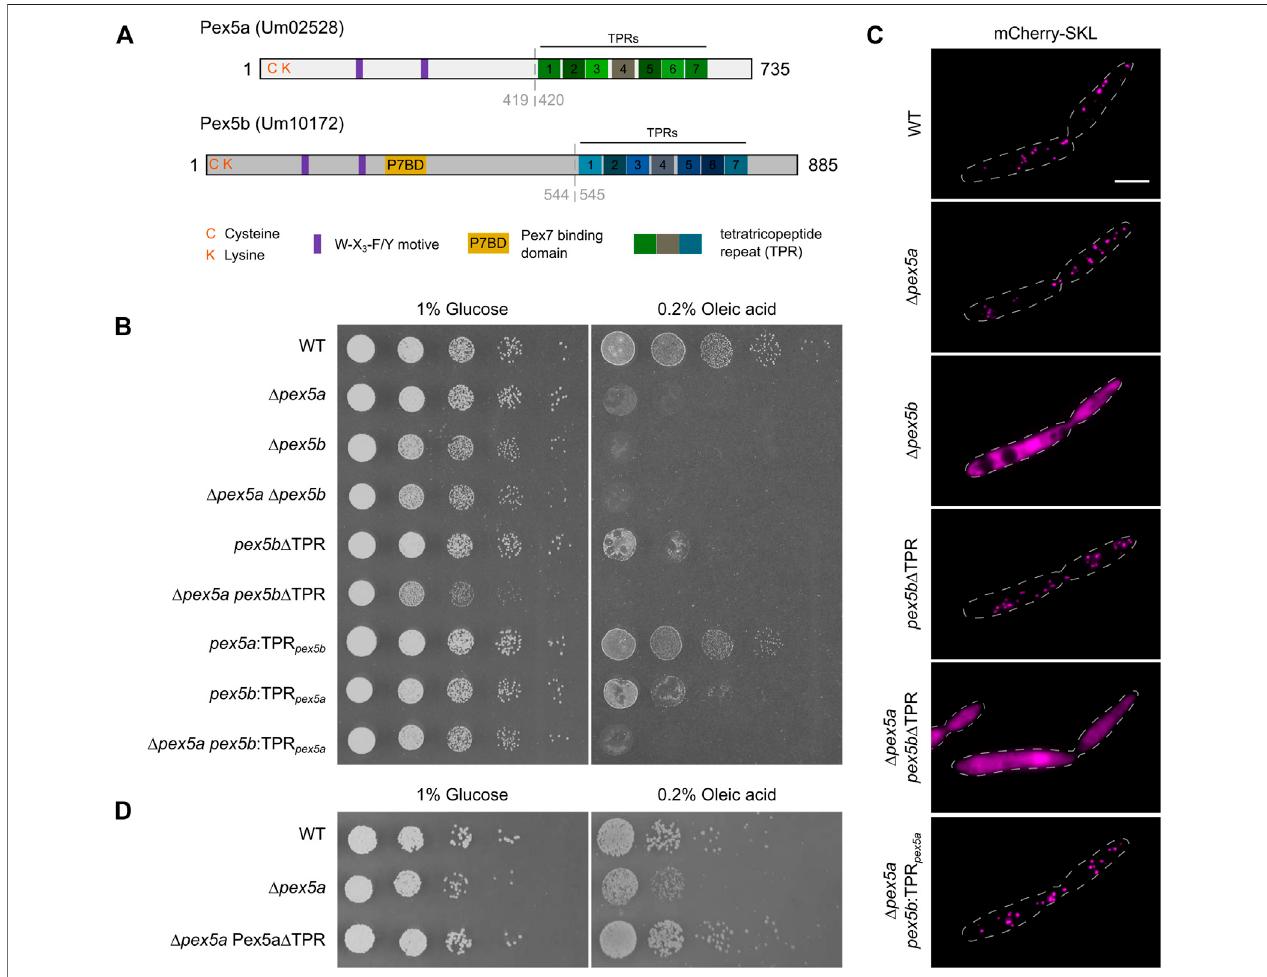
FIGURE 1 | Contribution of the N - and C -terminal domains of two Pex5 proteins to peroxisome function. (A) Scheme illustrating the domain organization of Pex5a and Pex5b from U. maydis . C and K refer to a cysteine and a lysine residue possibly involved in ubiquitination. Purple rectangles denote the position of W-X 3 -F/Y motifs required for docking complex interaction. A putative Pex7 binding domain (P7BD) of Pex5b is shown in yellow. The position of the TPR domains is highlighted with rectangles.Graydashedlinesindicatethepositionofdomainswapstogeneratechimeras(see SupplementaryFigureS3 ). (B) Serialtenfolddilutionsofindicated strains were spotted on minimal media containing either glucose or oleic acid as sole carbon source. Plates were photographed after 2 days of incubation at 23 ° C. The assays reveal that both the NTD and the CTD of Pex5a and Pex5b contribute to peroxisome function to a different extent. It is yet unclear why growth of mutants only expressingtheNTDofPex5bisheavilyaffectedonglucosemedia. (C) Fluorescencemicroscopicimagesofindicatedstrainsexpressingtheperoxisomalmarkerprotein mCherry-SKL. Scale bar represents 5 µm. Notably, the Δ pex5a pex5b :TPR pex5a mutant shows peroxisomal localization of mCherry-SKL but is heavily affected in the growthassays( Figure1B ). (D) Serialtenfolddilutionsofwildtypecells, Δ pex5a mutantsand Δ pex5a mutantsoverexpressingtheNTDofPex5awerespottedonminimal media containing either glucose or oleic acid as sole carbon source. Plates were photographed after 3 days of incubation at 23 ° C. Accordingly, Pex5a Δ TPR is a functional targeting